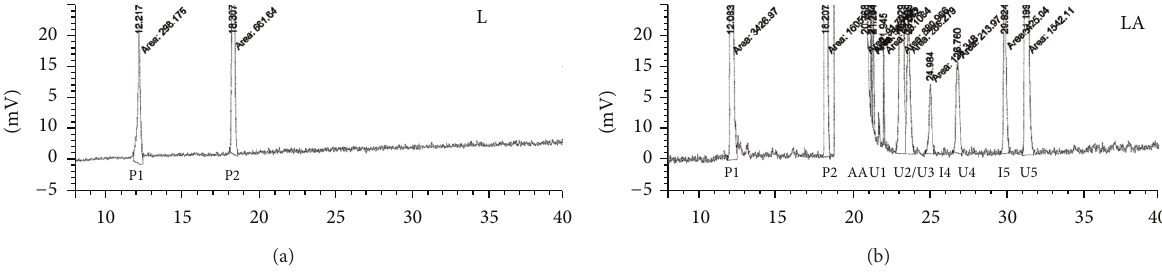
Figure 4: Chromatograms of HPLC-ELSD assessments: L—placebo, liposomal form of azelaic acid without the active substance; LA— liposomal form of azelaic acid; P1 and P2—impurities originating from the components of the formulation; AA—azelaic acid; I4 and I5— identified impurities; and U1–U5—unidentified impurities observed in the liposomal formulation of the azelaic